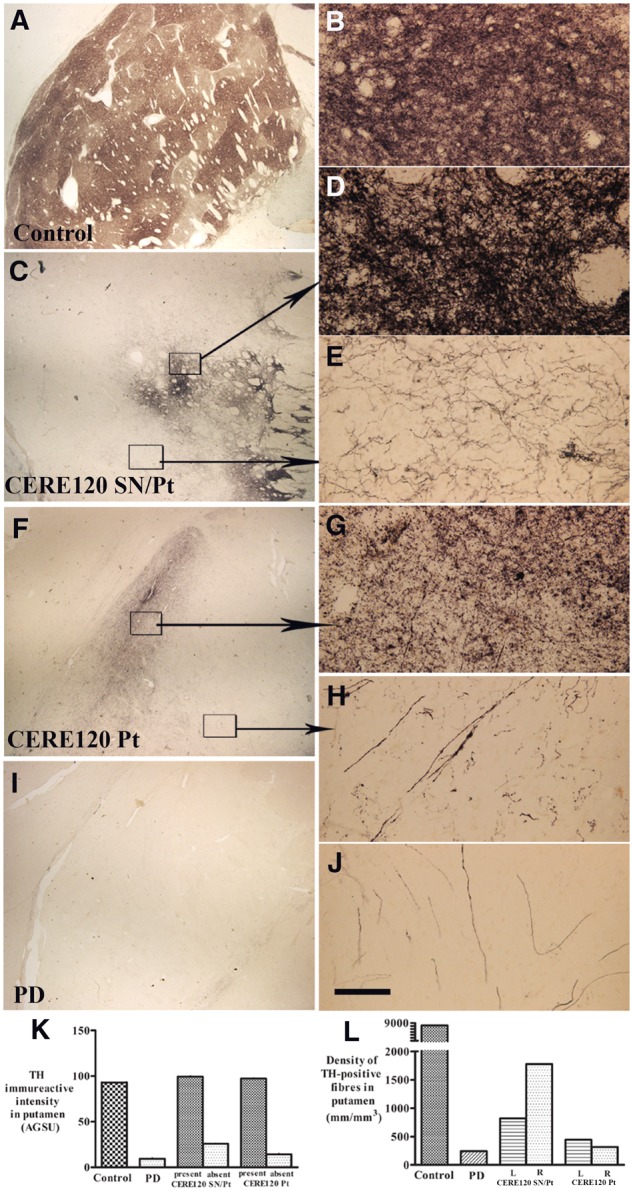

Qualitative and quantitative evaluation for TH expression in putamen with or without CERE120 delivery. Sections through the mid-putamen show TH-immunoreactive patterns in age-matched control (A and B), Parkinson’s disease with combined nigral and putamenal CERE120 delivery (CERE120 SN/Pt; C–E), Parkinson’s disease with putamenal delivery only (CERE120 Pt; F–H), and Parkinson’s disease without gene delivery (I and J). Note that there were dense TH-positive fibres in the CERE120 delivery areas (C, D, F and G) and scattered TH-positive fibres in the areas remote from CERE120 delivery (E and H). Scale bar in D = 100 µm for B, D, E, G, H and J and 1.6 mm for A, C, F and I. (K) Densitometry revealed that putamenal areas with CERE120 (present) displayed higher TH-immunoreactive intensity similar to the levels of age-matched control whereas areas absent CERE120 (absent) exhibited much lower TH-immunoreactive intensity close to the levels of Parkinson’s disease without gene delivery. (L) Stereological analyses of TH-positive fibre density throughout putamen demonstrated that Parkinson’s disease with combined nigral and putamenal CERE120 delivery displayed higher density than the Parkinson’s disease with putamenal CERE120 delivery only. PD = Parkinson’s disease.